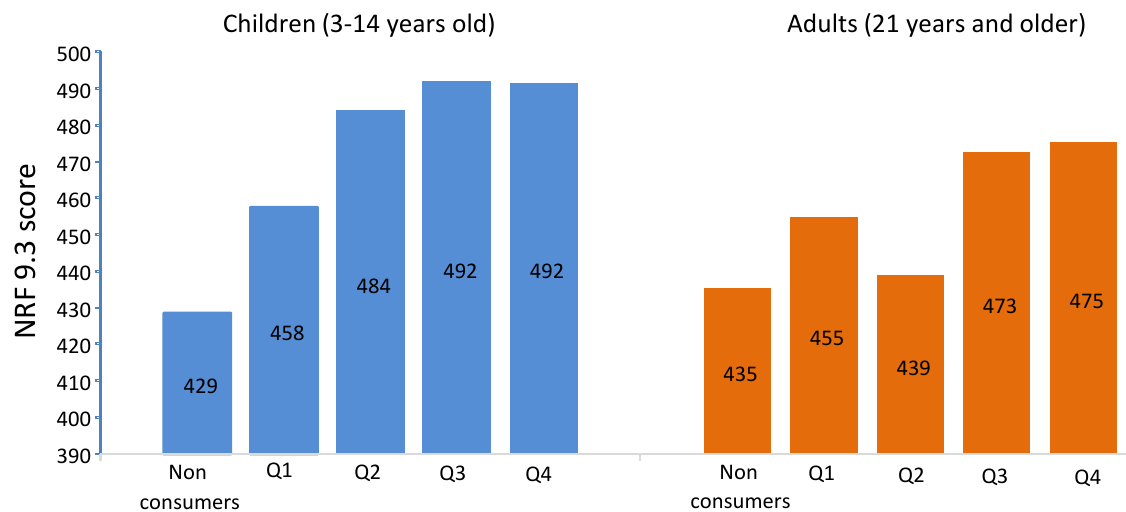
Figure 2. NRF9.3 score values (y axis) for FVJ (fruit and vegetable juices) non consumers and for consumers stratified by quartiles of consumption. Data are presented for children and for adults. The NRF9.3 score was calculated using free sugars in the LIM subscore.